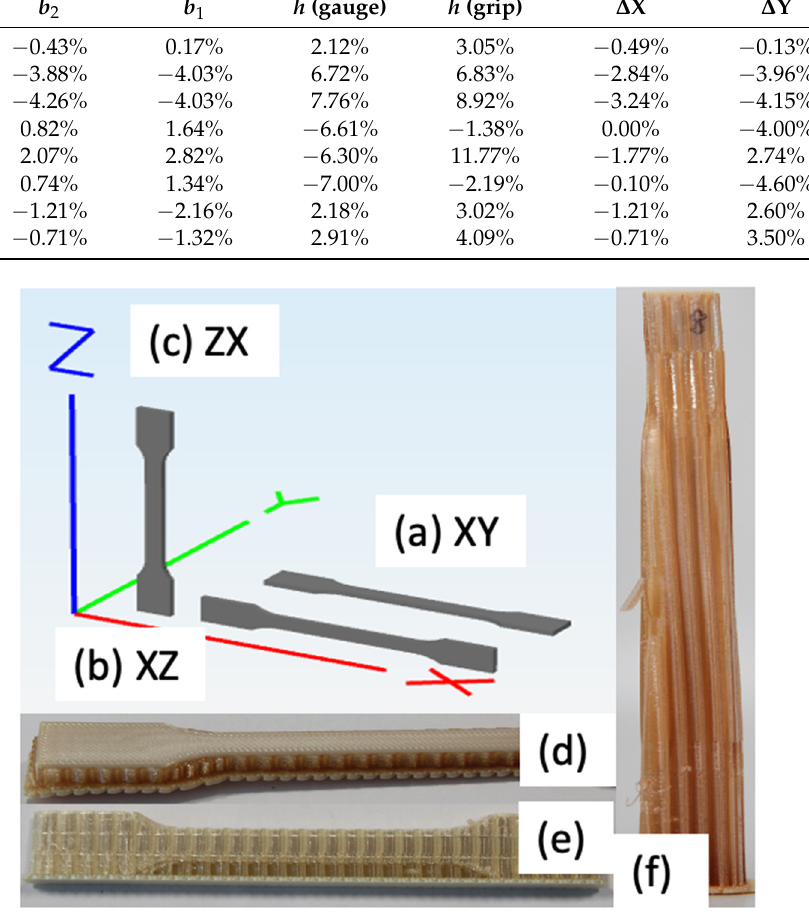
Figure 5. X, Y, and Z axis for coupons: ( a ) XY (Coupons 1, 5, 9), ( b ) XZ (Coupons 2, 6, 7), and ( c ) ZX (Coupons 3, 4, 8). Annealed specimens with co-printed supporting structures ( d ) Coupon 1, ( e ) Coupon 6, ( f ) Coupon 8.